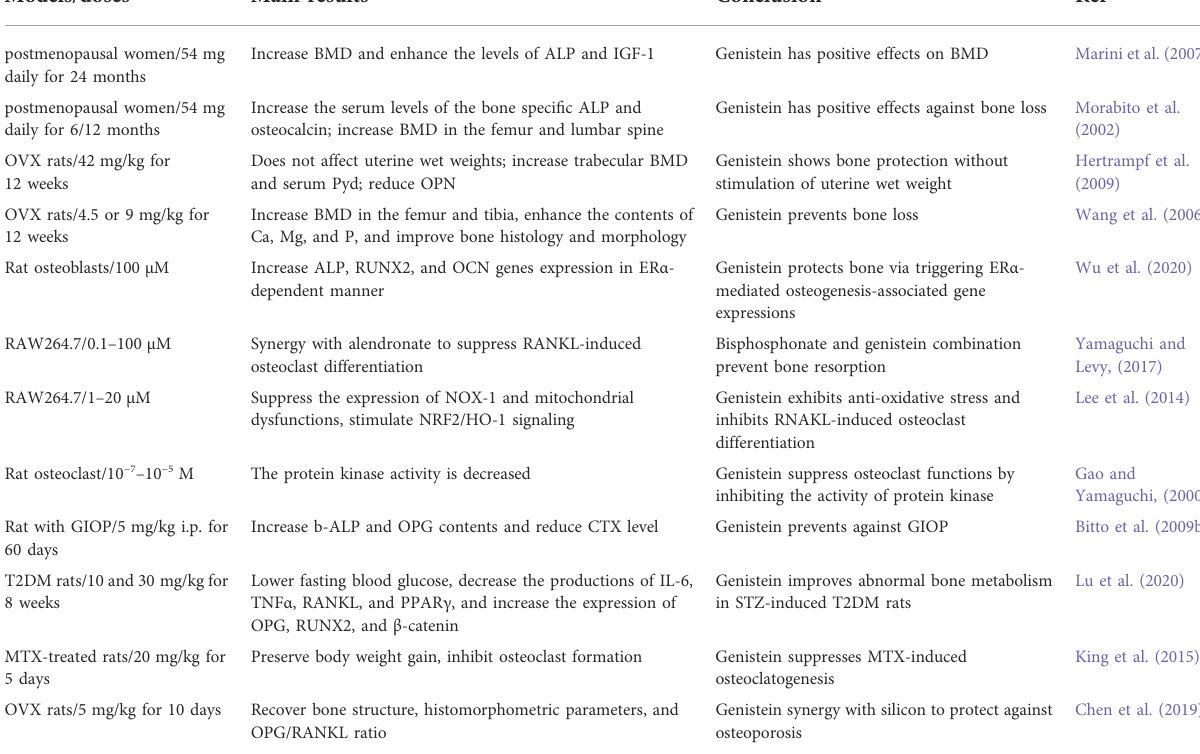
TABLE 1 The biological effects of genistein on osteoporosis.